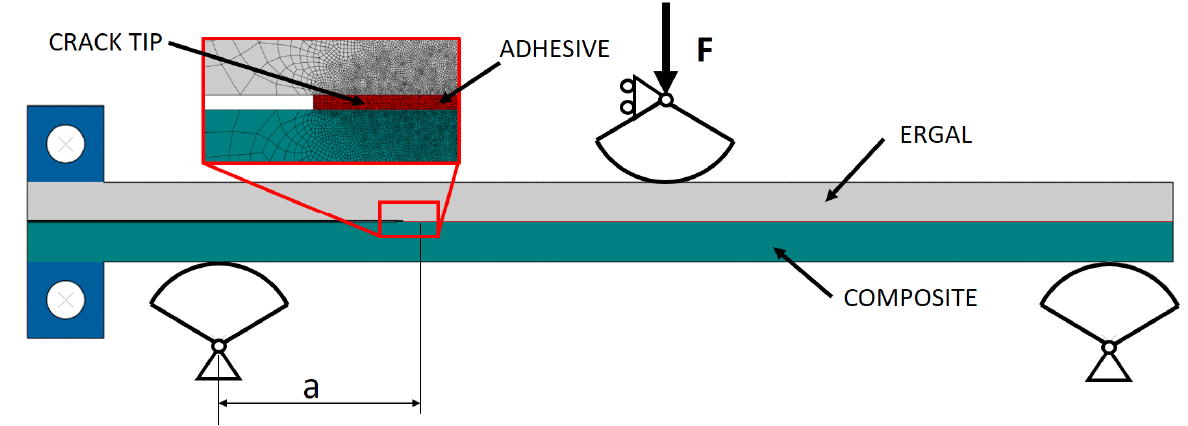
Figure 5. Details of the FE model for the ENF joints.